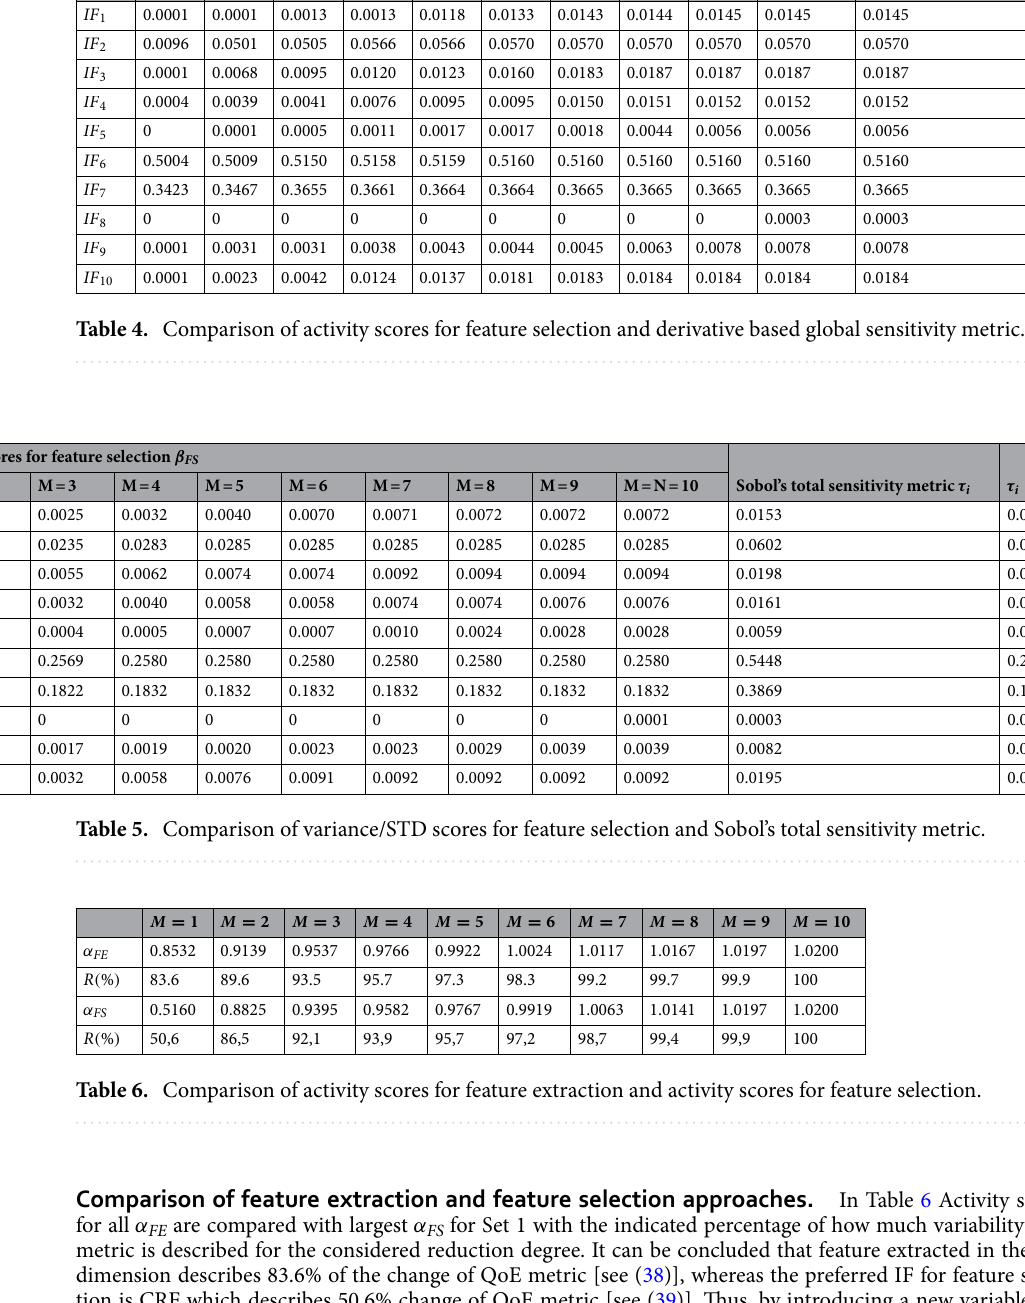
Comparison of feature extraction and feature selection approaches. In Table 6 Activity scores